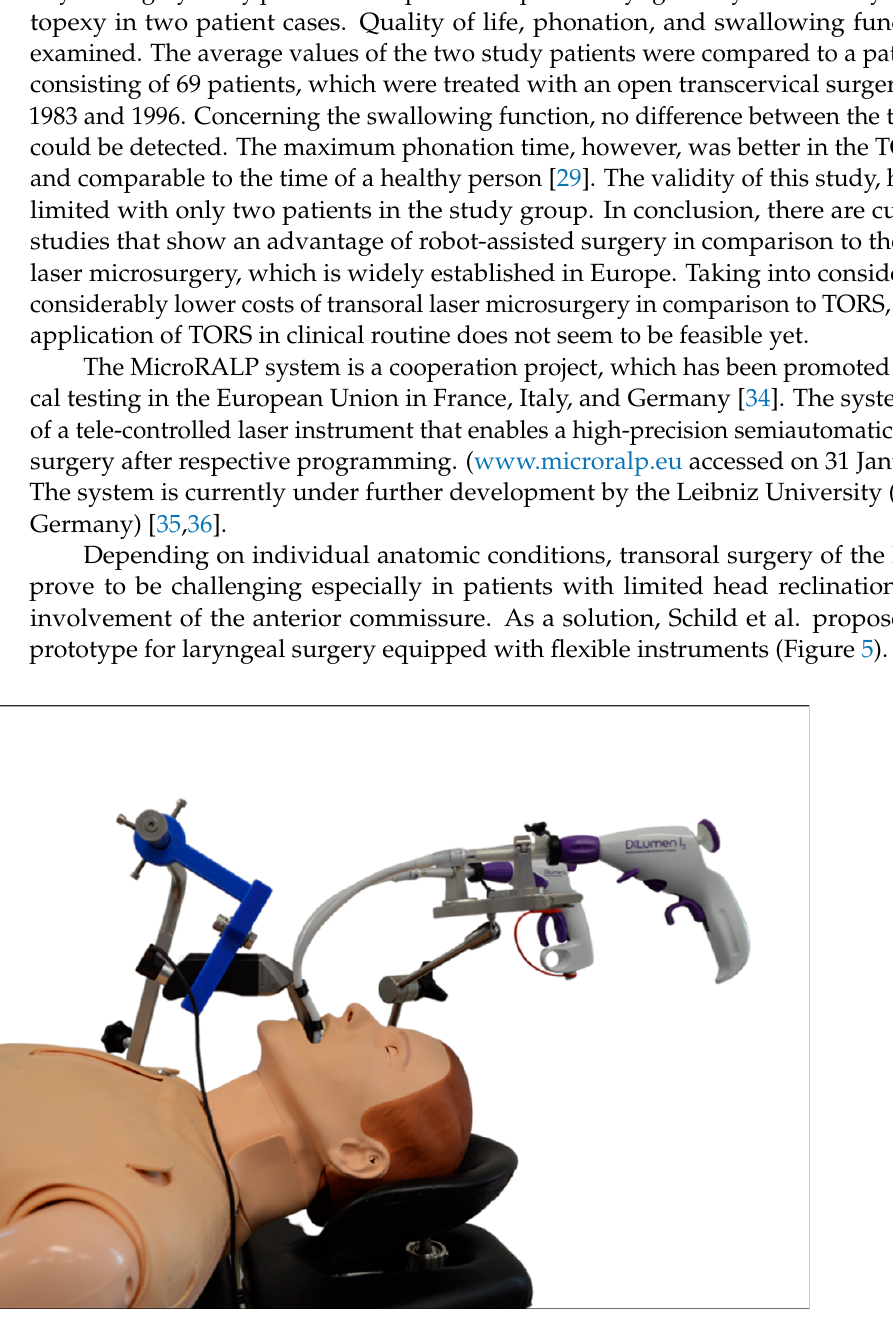
Figure 5. Curved prototype of a video laryngoscope equipped with flexible instruments for laryngeal surgery. Reproduced with kind permission from Schuler et. al., Ulm University Medical Center, Ulm, Germany, © 2020.